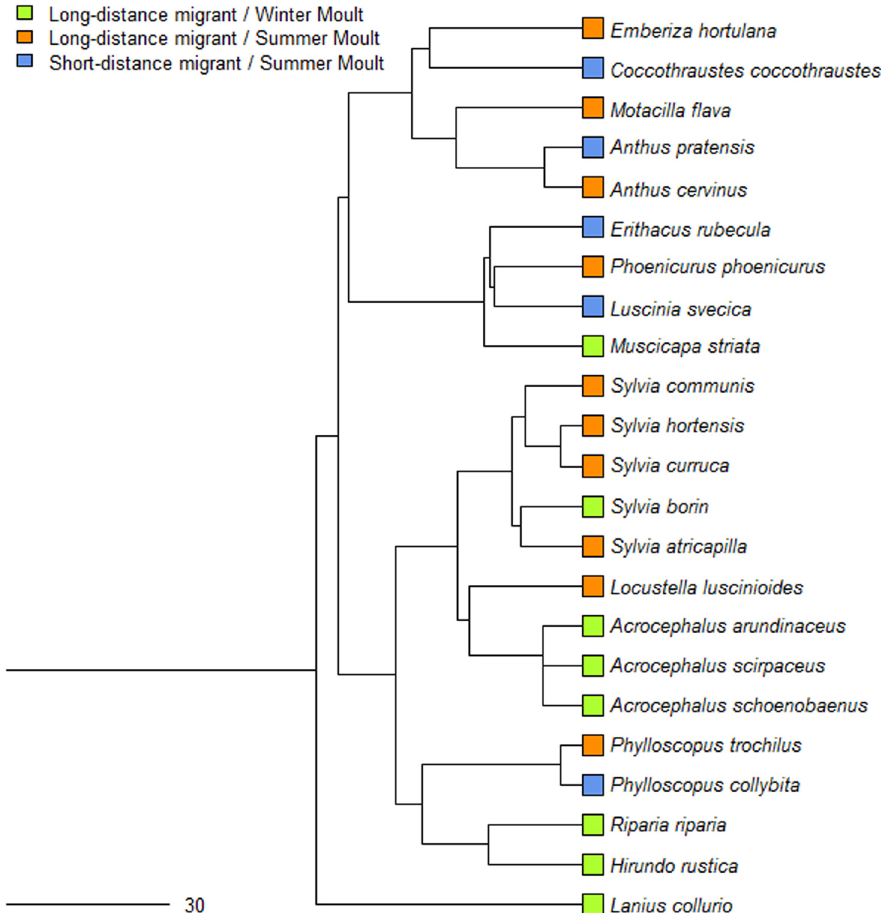
Fig 2. Phylogenetic tree for the 23 species included in analysis based on BirdTree.org